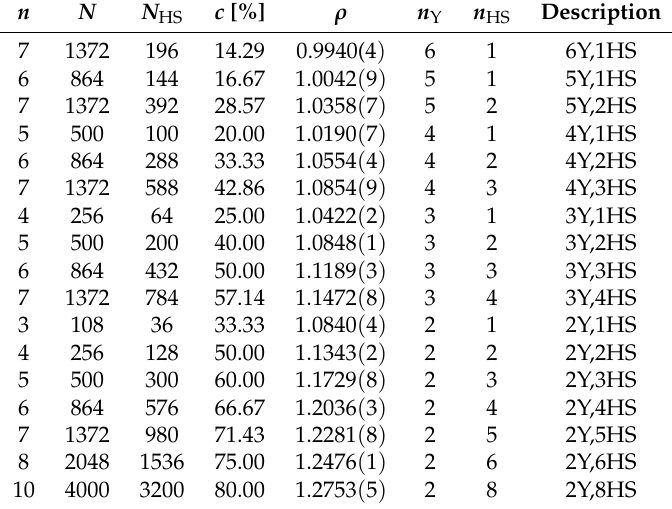
Figure 1. Typical structure of a studied crystal with nanolayers parallel to the (111) crystallographic plane. Yukawa’s particles are denoted with a green color and the hard spheres are marked with a red color. ( a ) a system with nanolayers consisting of a monolayer of hard spheres can be also seen as multilayer Yukawa system. This system is denoted in the text as 1HS or 6Y; ( b ) a system with nanolayers consisting of double layer of hard spheres; ( c ) a system with nanolayers consisting of four layers of hard spheres; ( d ) a system with nanolayers consisting of a monolayer of particles that interact via Yukawa potential. For more details, see Table 1. Table 1. Examples of structural modifications of studied systems. Each structure was based on the face-centered cubic (fcc) lattice which unit cell contains four atoms. n is the number of unit cells in direction’s x , y , z . N = 4 n 3 is the number of particles in the system. N HS is the number of particles in nanolayers. c is the concentration of nanolayers particles in the system. ρ = N / V is the density of the system. n Y is the number of layers of Yukawa particles in a nanolayer. n HS is the number of layers of hard spheres in a nanolayer. The description column holds the abbreviations that indicate the number of layers in a nanolayer, and are used in figures and in the text to refer to those systems. n N N